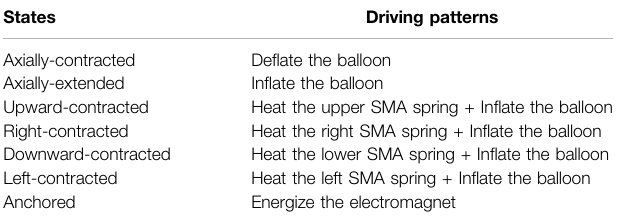
TABLE 1 | States and driving patterns of the robot segments. States Driving